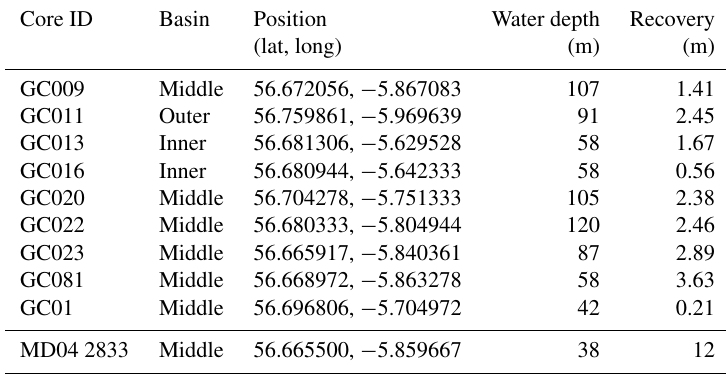
Table 1. Details of the sediment cores extracted from Loch Sunart that were used in this study. Core ID Basin Position Water depth Recovery (lat, long) GC009